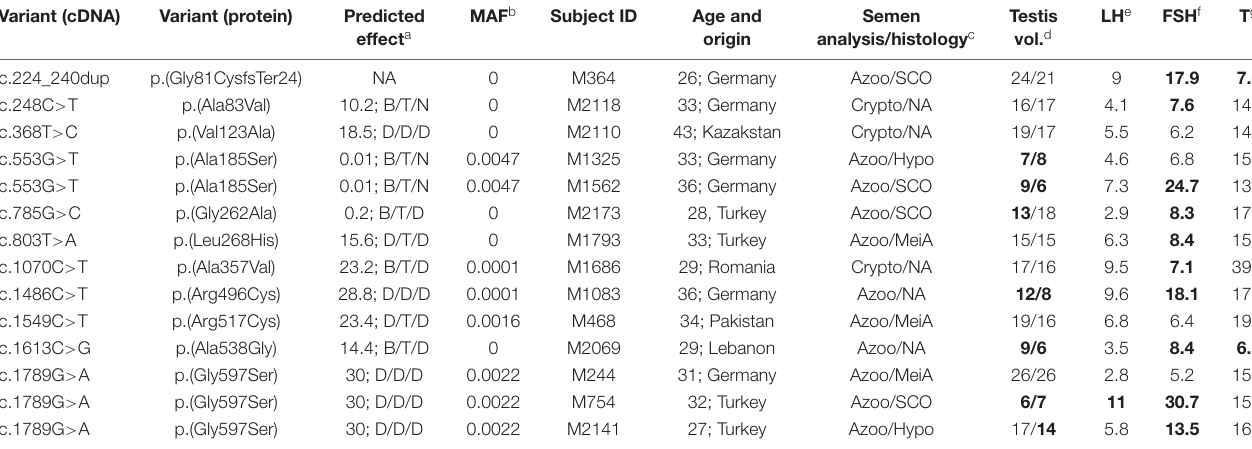
TABLE 1 | TRIM71 variants identified in infertile men within the MERGE